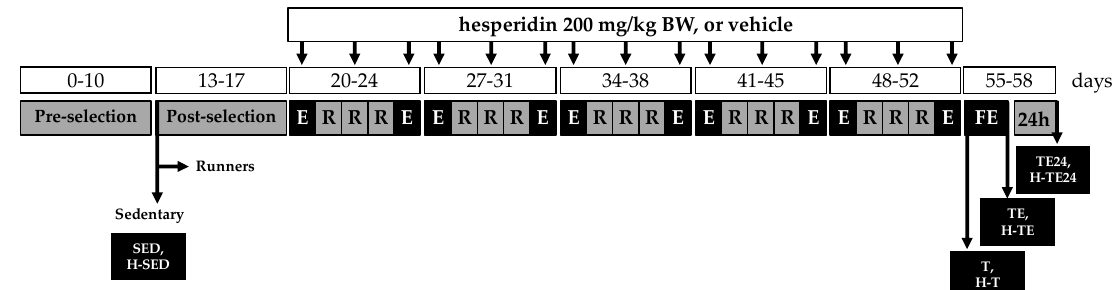
Figure 1. Experimental design. E = exhaustion test; FE = final exhaustion test; R = running training; T = vehicle-trained group; H-T = hesperidin-trained group; TE = T group with an additional exhaustion test; H-TE = H-T group with an additional exhaustion test; TE24 = TE group 24 h after the exhaustion test; H-TE24 = H-TE group 24 h after the exhaustion test.